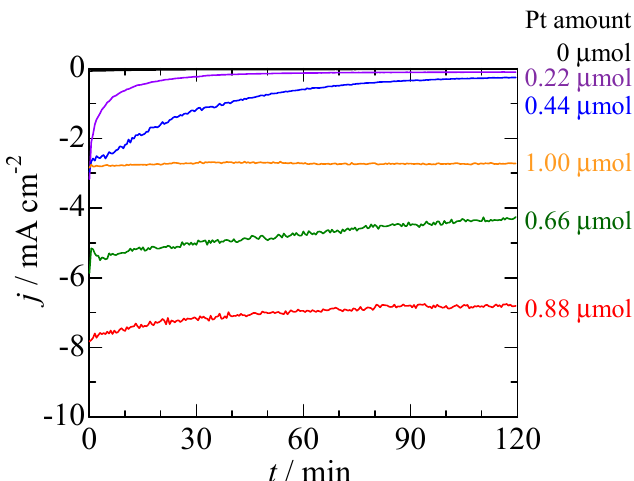
Figure 7. Current–time profiles of Pt / CdS / CuInS 2 electrodes measured at 0 V under irradiation with visible light ( λ > 420 nm).